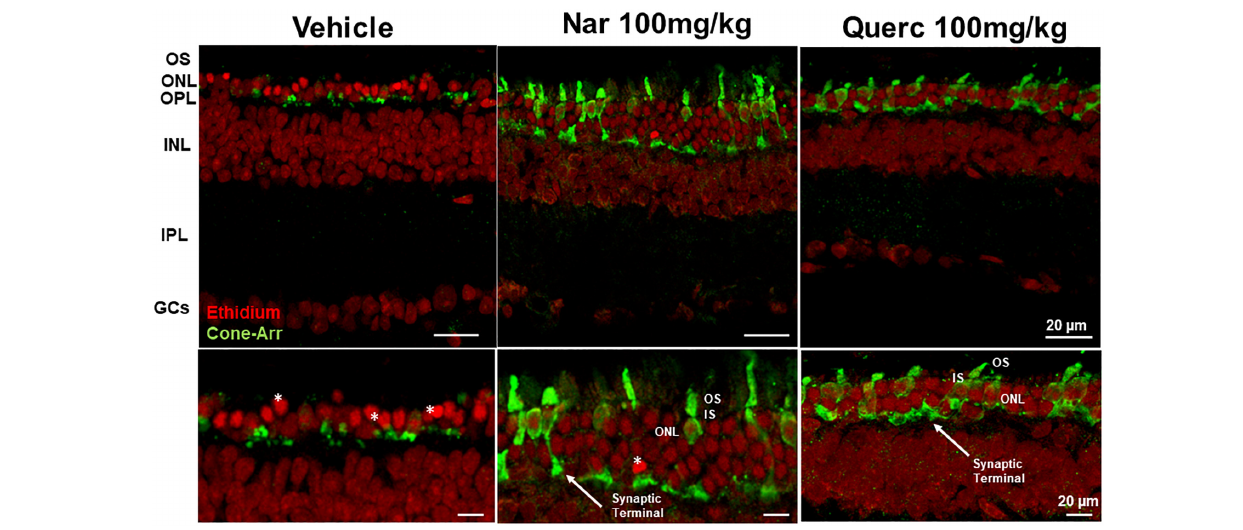
FIGURE 3 | Morphological effects of chronic treatment with naringenin and quercetin on the outer retina. Immunohistochemistry for cones (cone-arrestin in green) and nuclear layers (Ethidium bromide in red). Cone-arrestin staining revealed the protective effect of chronic treatment of both nutraceutical compounds on degeneration of cone photoreceptors. OS, outer photoreceptor segments; ONL, outer nuclear layer; OPL, outer plexiform layer; INL, inner nuclear layer; IPL, inner plexiform layer; GCs, ganglion cells; ∗ , pyknotic